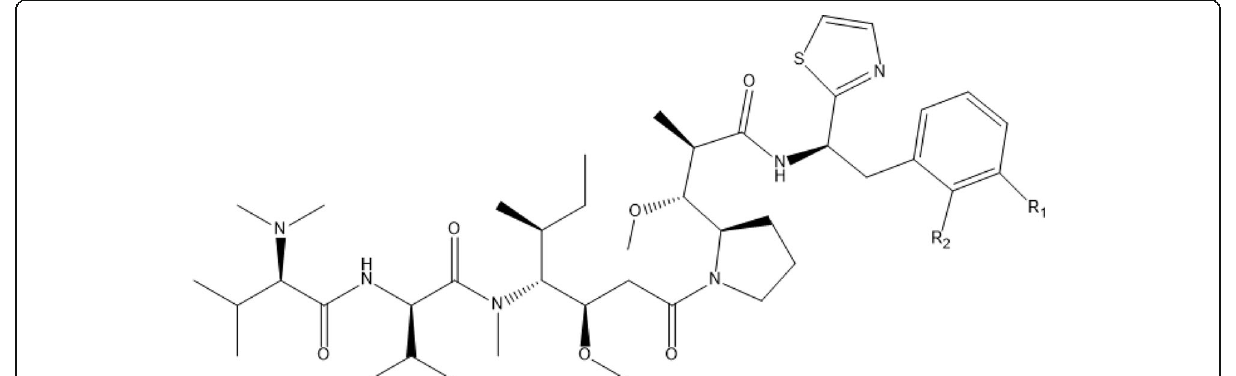
Fig. 3 Structure of the template (compound 39) used for design